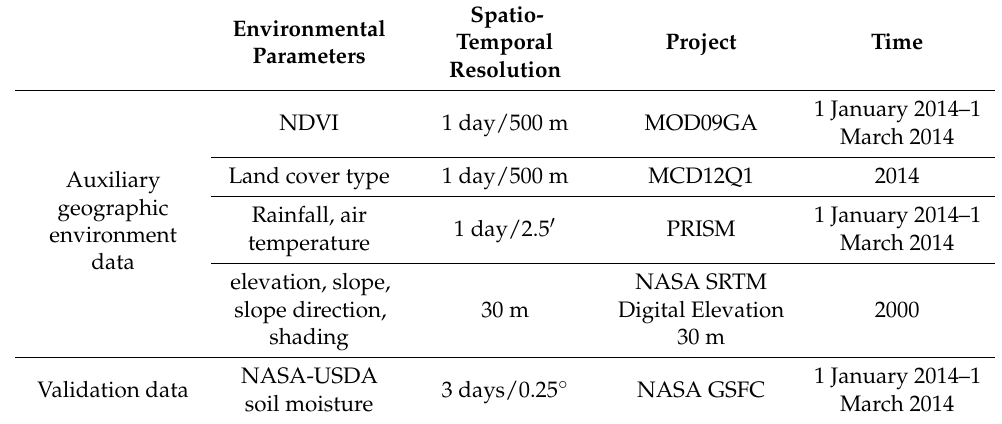
Table 2. Auxiliary data used in the